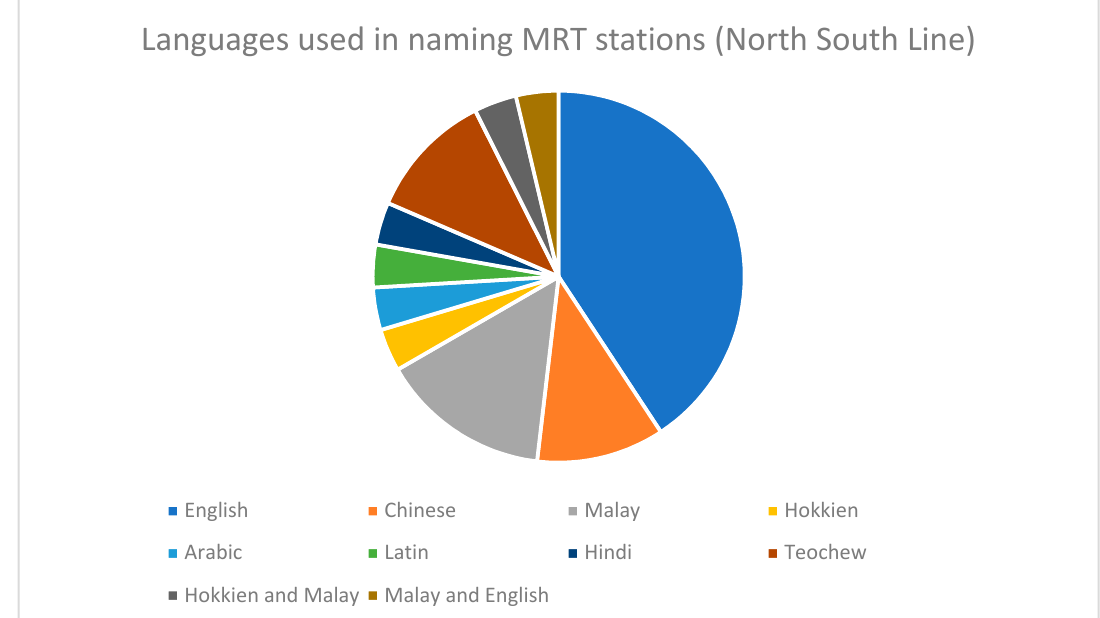
Figure 1. Languages used in naming the Mass Rapid Transit (MRT) stations on the North South Line.